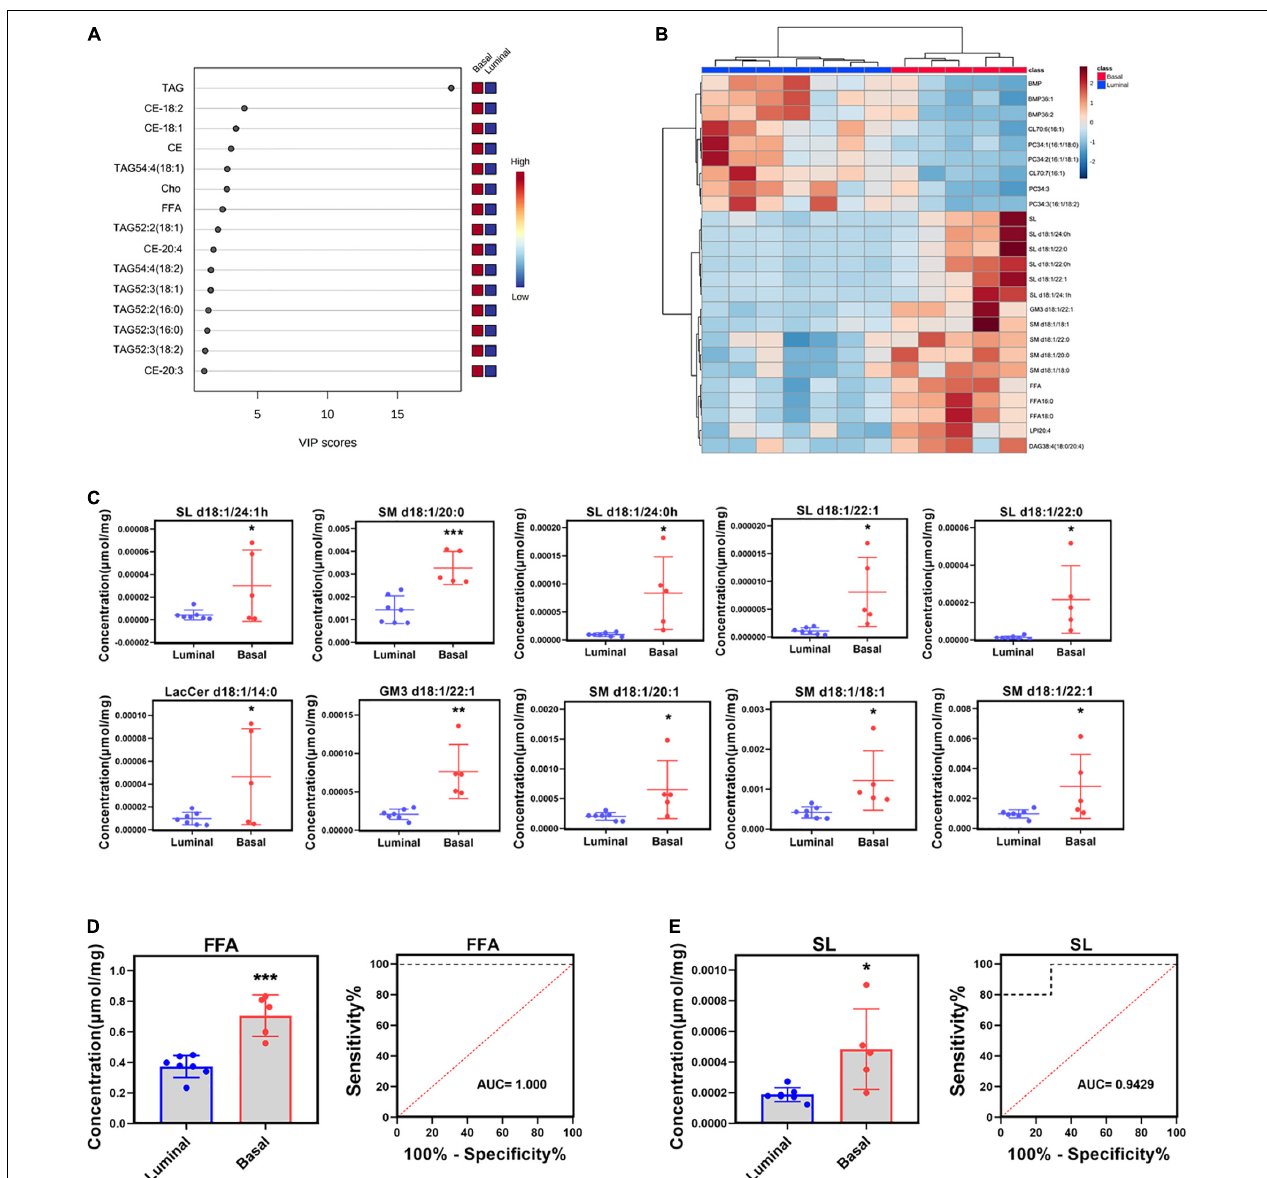
FIGURE 3 | Potential lipid biomarkers of basal and luminal MIBC subtypes. (A) VIP score of altered lipid elements. (B) Heatmap of the top 25 altered lipid elements in basal and luminal MIBC subtypes. (C) The levels of the top 10 significantly differential lipid constituents in basal and luminal MIBC subtypes. (D,E) FFA and SL levels and AUC values. * indicates p < 0.05; ** indicates p < 0.01; and *** indicates p <